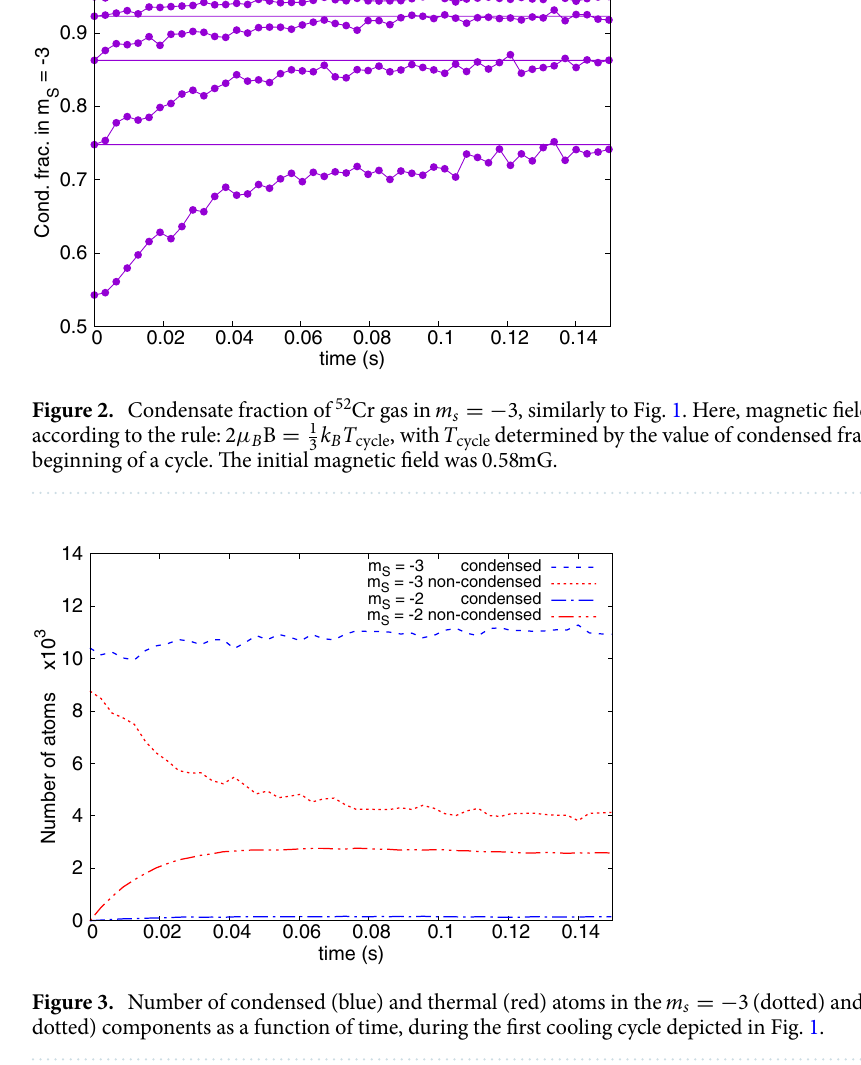
Figure 3. Number of condensed (blue) and thermal (red) atoms in the m s dotted) components as a function of time, during the first cooling cycle depicted in Fig.